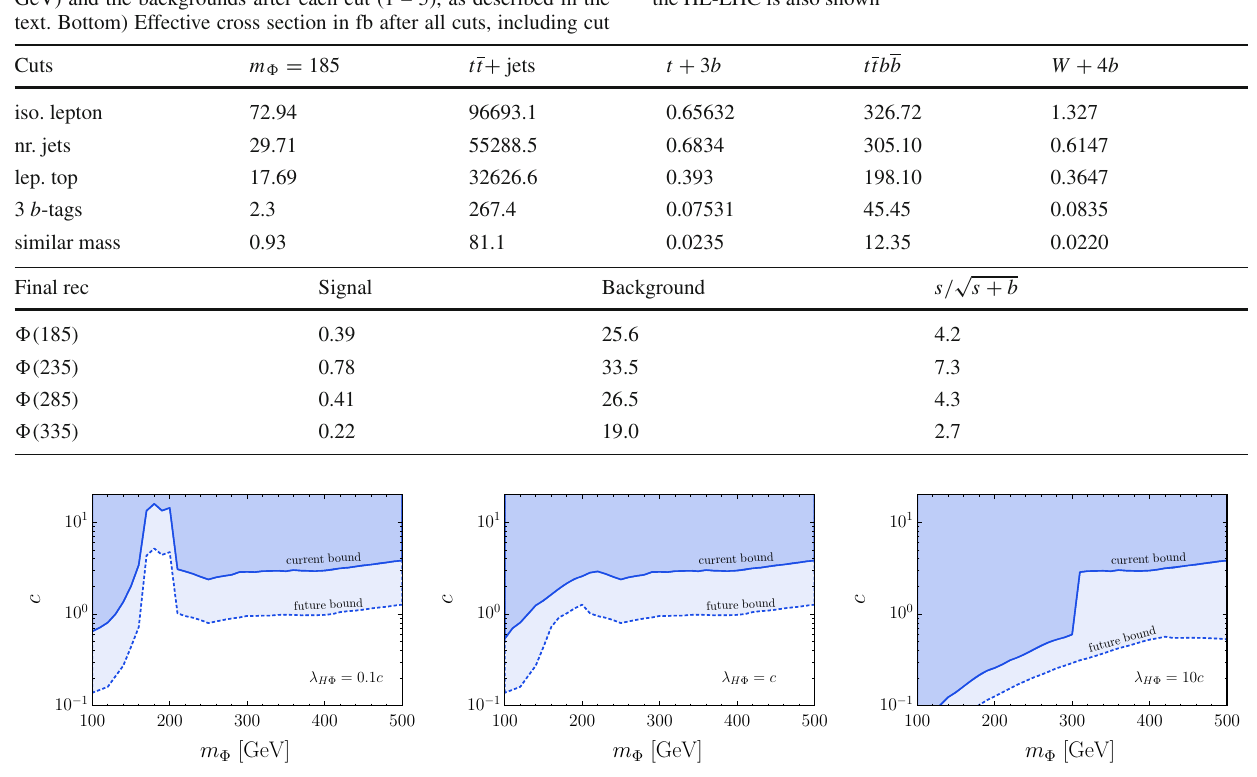
6, for different signals and for the total background. The sensitivity at the HL-LHC is also shown